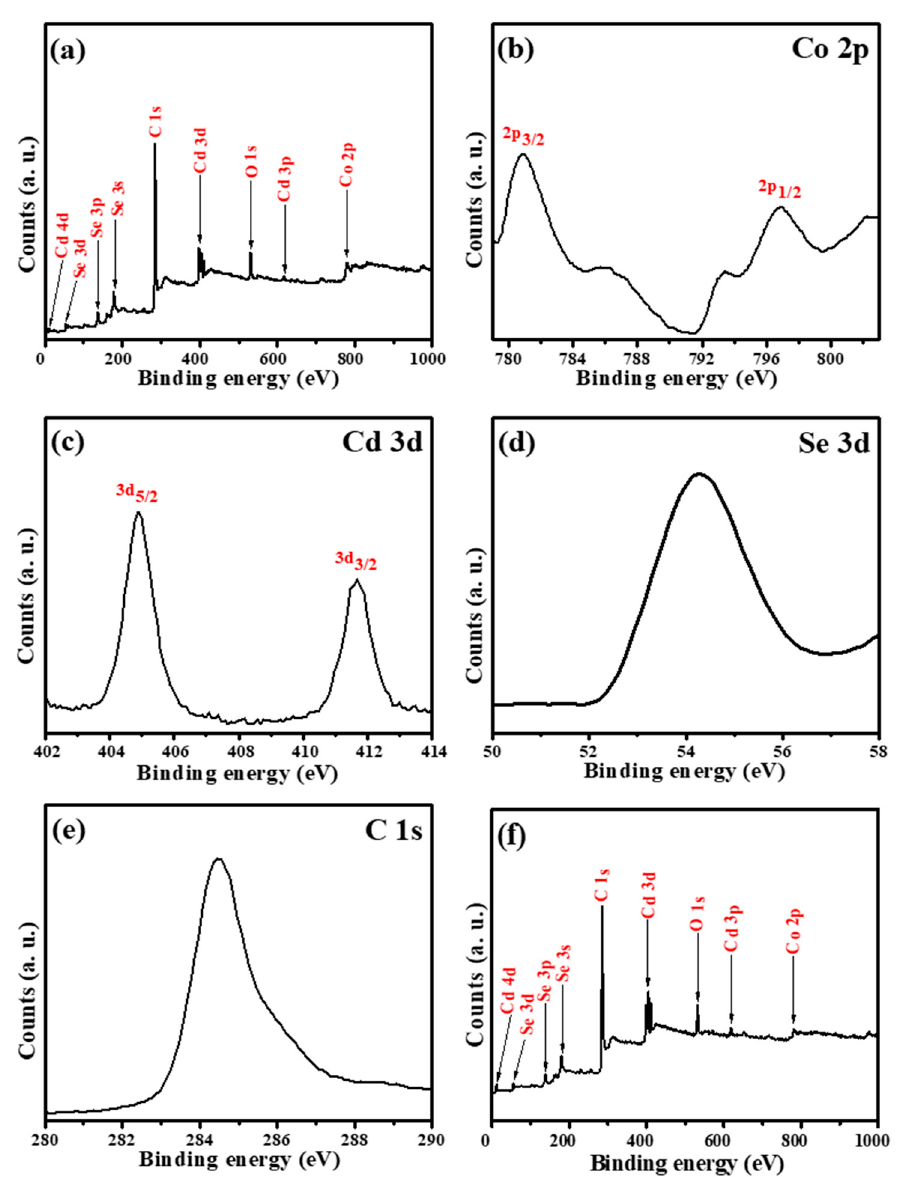
Figure 6. XPS spectra: ( a ) survey spectrum of Co-CdSe@ECNFs. Panels ( b – e ) represent the high-resolution spectra of Co 2p, Cd 3d, Se 3d, and C 1s, respectively, and ( f ) represents the survey spectrum of utilized Co-CdSe@ECNFs.